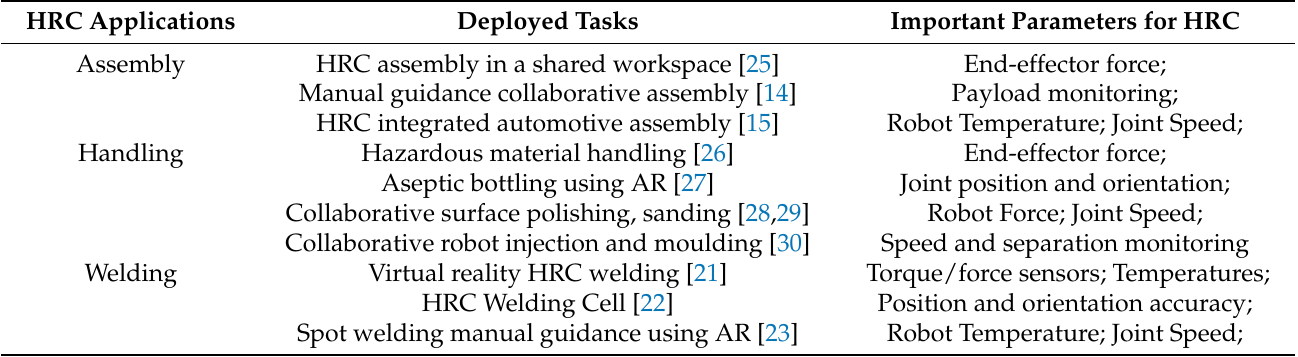
Table 1. Human-robot interaction (HRC)